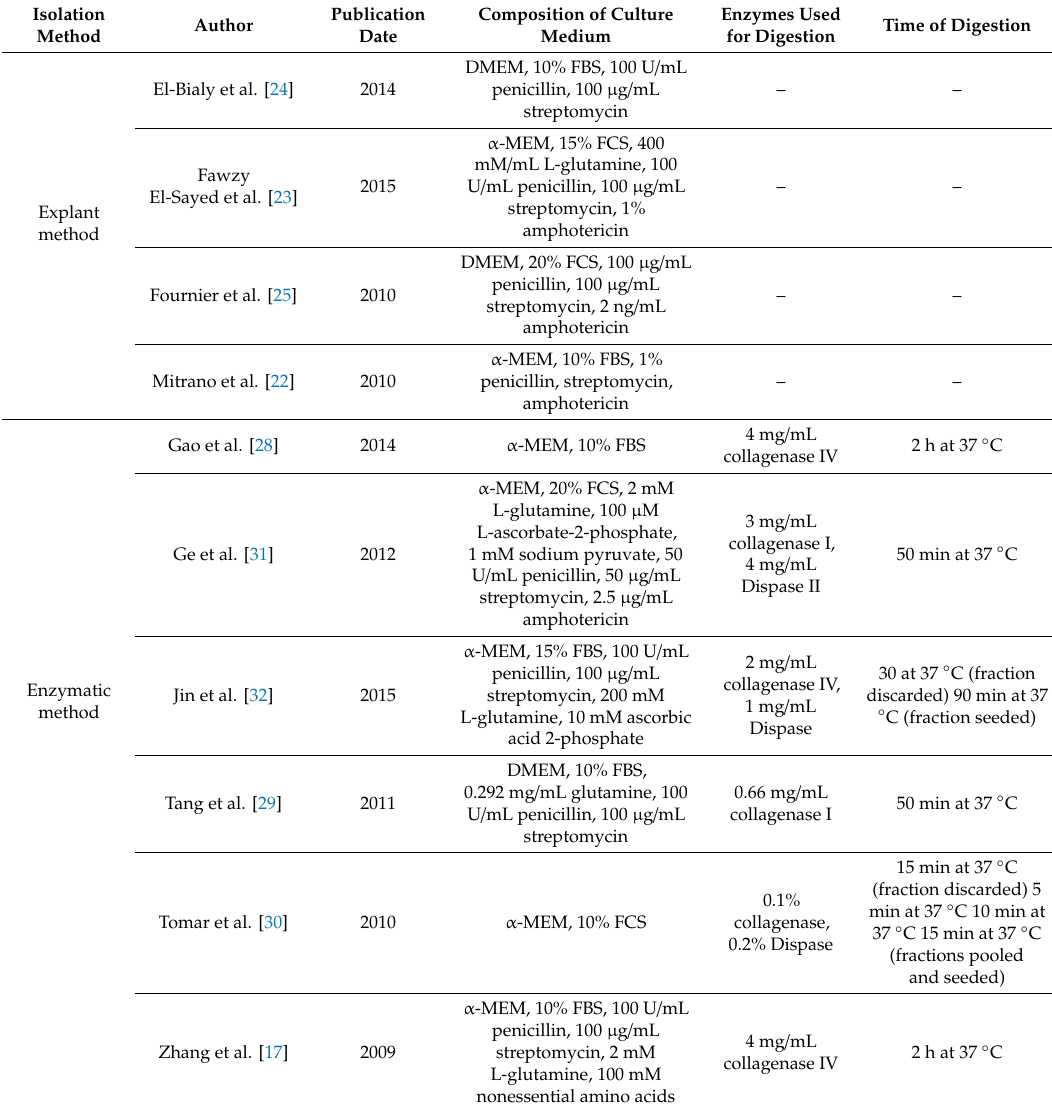
Table 1. Overview of gingival mesenchymal stem cells (GMSCs) isolation and culture